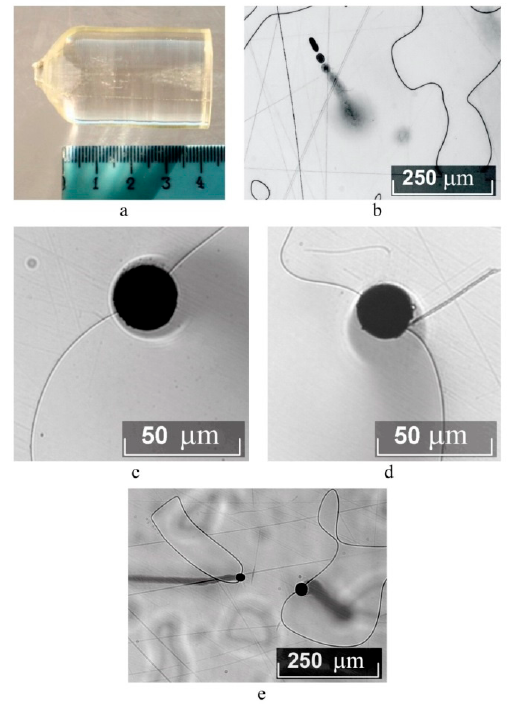
Figure 1. ( a )–shape and accumulation of “channel” macrodefects at the bottom of the LiNbO 3 :B (~3.50 ⋅ 10 –5 wt% in a crystal cone) crystalline boule; ( b )–a separate macrodefect of the “channel”